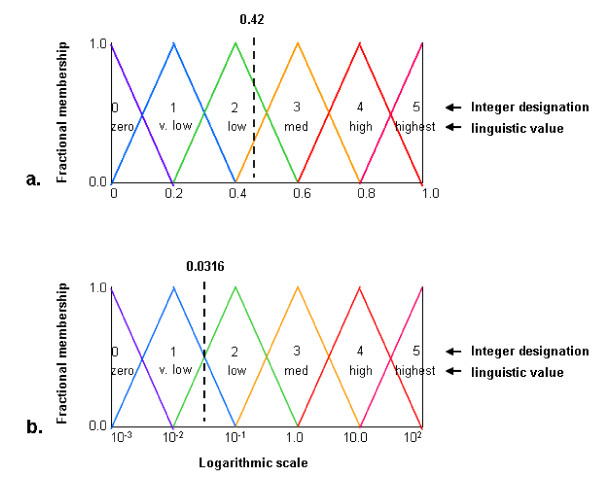
a.Triangular membership functions on the interval 0 to 1. Linguistic values and equivalent integer designations are shown with each membership function. Centroids for the triangular functions evenly divide the interval into five segments. All examples in this paper used these membership functions, except that the length of the interval was varied in some cases, or the centroids were adjusted. An example of fuzzification of the real value 0.42 is: 0.42 = 0.9 (0.4) + 0.1 (0.6) = 0.9 low + 0.1 medium. B. triangular membership functions are linear on the log of the values. For example, if the range is [10-3, 102], then 0.0316 = sqrt(0.001) is fuzzified by linearly combining logarithms of the fuzzy set values. Log(0.0316) = -1.5 = 0.5 log(10-2) + 0.5 log(101) = 0.5 very low + 0.5 low.